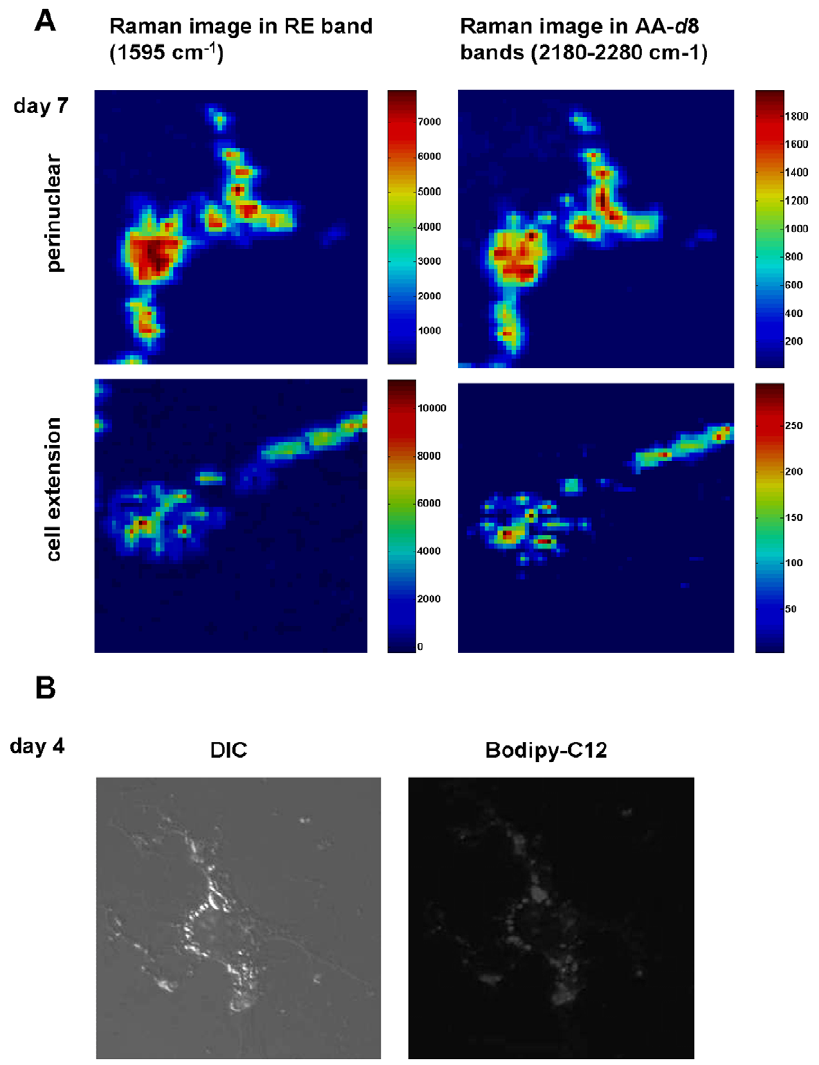
Figure 4. HSCs contain a metabolically homogenous population of LDs. A. Freshly isolated HSCs were cultured for 6 days and additionally incubated with 25 m M deuterated arachidonic acid (AA- d 8) for another 24 h. After fixation confocal Raman microspectroscopy was performed as described. Raman images in the 1595 cm 2 1 (RE) and 2180–2280 cm 2 1 (AA- d 8) regions are shown in arbitrary units for LD enriched sites perinuclearly (upper panels) and at the cell extension (from a different cell; lower panels). B. To determine metabolic activity of HSC LDs, freshly isolated HSCs were cultured for 4 days and subsequently incubated for 5 h with 25 m M Bodipy C-12. After fixation cells were analyzed by fluorescence microscopy.